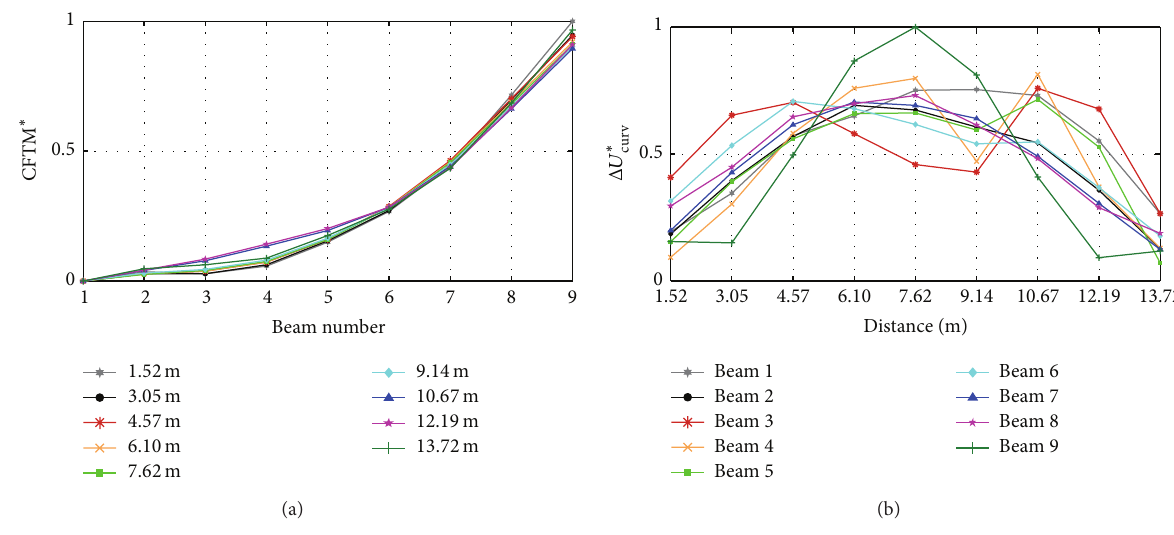
for damage case 6. curv